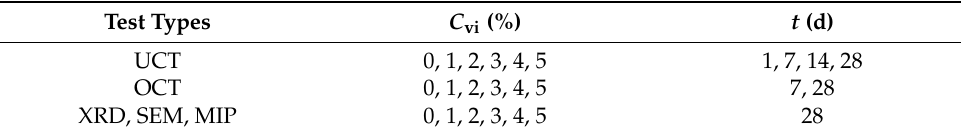
Table 3. Arrangements for mechanical and microscopic